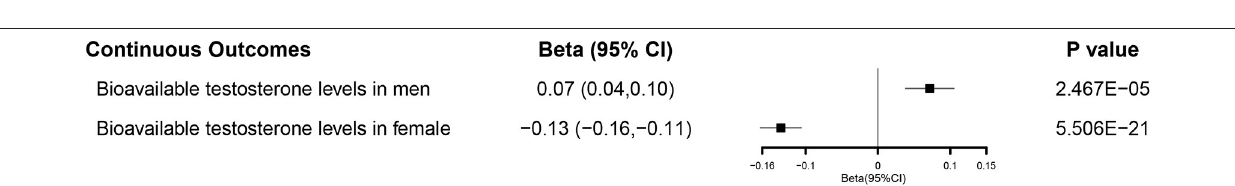
FIGURE 2 | Forest plot of the MR results between EA and 12 binary outcomes including prostate cancer, bladder cancer, kidney cancer, testicular cancer, kidney stone, BPH, prostatitis, cystitis, incontinence, ED, male infertility, and female infertility. MR, Mendelian randomization; EA, educational attainment; BPH, benign prostatic hyperplasia; ED, erectile dysfunction; OR, odds ratio; CI, confidence interval.